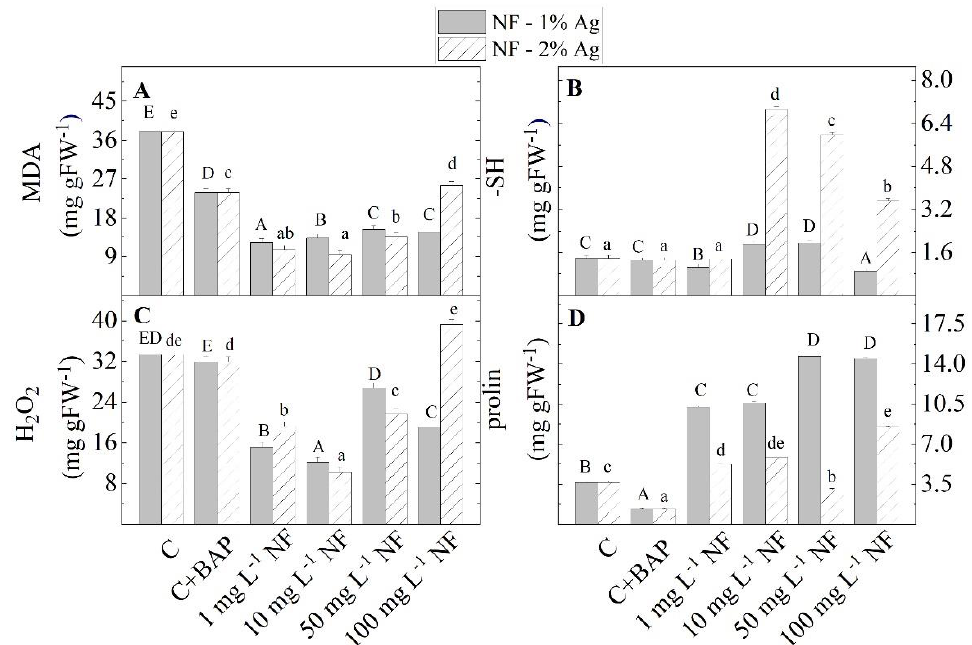
Figure 7. The levels of stress markers (MDA ( A ), -SH groups ( B ), H 2 O 2 ( C ), and proline ( D )) in the S. rebaudiana plantlets in vitro propagated on MS medium, on MS medium with BAP, and on MS medium supplemented with various concentrations (1, 10, 50, 100 mg L − 1 ) of aminoacid nanofibers enriched with 1% and 2% colloidal Ag (NF-1%Ag, NF-2%Ag). Values are means ± SE, n = 20; different letters indicate significant differences assessed by the Fisher LSD test ( p ≤ 0.05) after performing ANOVA one-way analysis. We used the letter ‘a’ or “A” for the lowest data value and ascended to the next letters for higher data value. The statistical analysis of NF-1%Ag (uppercase) and NF-2%Ag (lowercase) was performed separately.